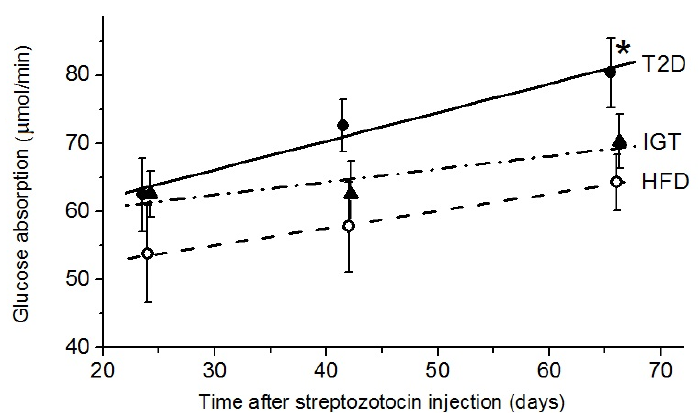
Figure 5. The maximal rate of the absorption of glucose ( µ mol/min) in the small intestine of rats with type 2 diabetes (T2D), with impaired glucose tolerance (IGT) and in the HFD control group (a high-fat diet) at different periods of the experiment. The T2D group ( n = 4), the IGT group ( n = 6) and the HFD group ( n = 6). Results are expressed as means ± the standard error of the mean (SEM). Straight lines are the regression lines. Student t -test: * p < 0.05 compared with the HFD group.